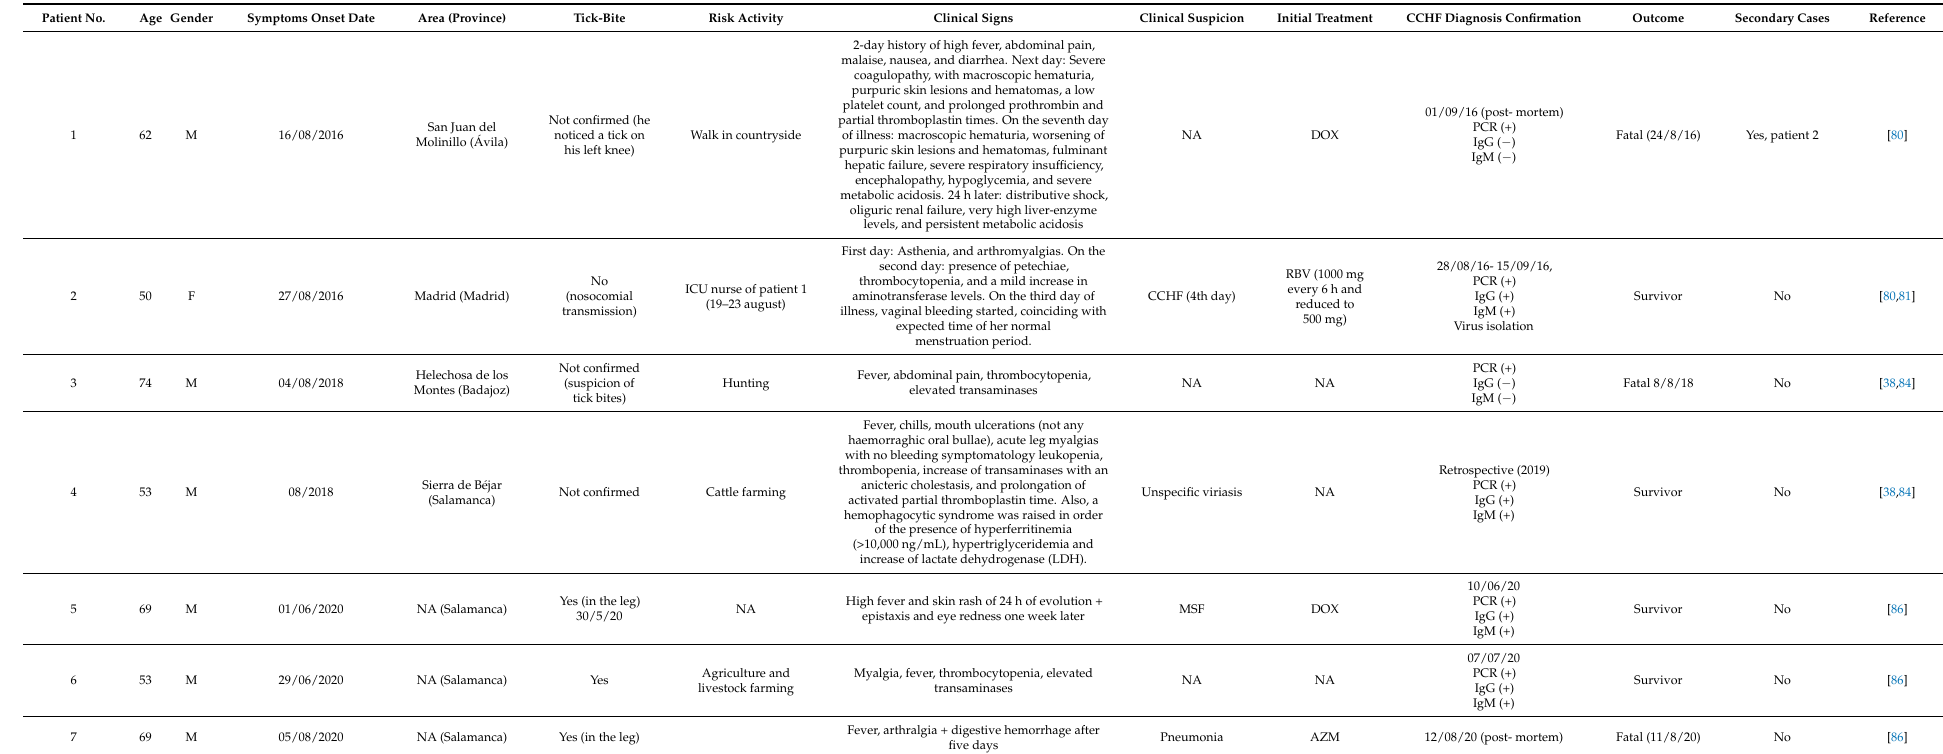
Table 3. Cases of Crimean-Congo hemorrhagic fever (CCHF) in Spain (confirmed by molecular biology